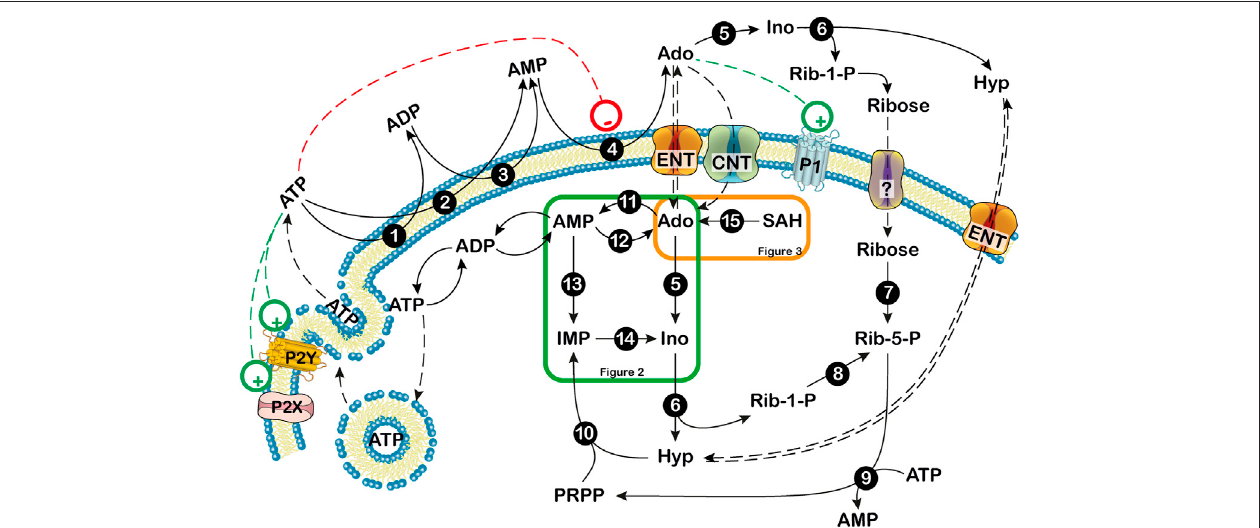
FIGURE 1 | Extra- and intracellular adenosine production. Extracellularly, ATP can be dephosphorylated to AMP by ectonucleoside triphosphate diphospho- hydrolase (CD39) or ecto-nucleotide pyrophosphatase/phosphodiesterase. Then, AMP can be dephosphorylated to adenosine by the extracellular 5 ′ -nucleotidase, CD73. Extracellular adenosine can be converted into hypoxanthine (Hyp) and ribose-1 phosphate (Rib-1-P) by the combined action of ectosolic adenosine deaminase and purine nucleoside phosphorylase. Extracellular Rib-1-P might be dephosphorylated by membrane phosphatases and equilibrates with the intracellular ribose through a not yet de fi ned transporter (?). Inside the cell, at low energy charge, adenosine originates mainly from AMP and can be exported or deaminated. When extracellularadenosinegeneratedfromATPbreakdownistransportedinsidethecell,itmightbephosphorylatedbythelowK M ADKordeaminatedbythehighK M ADAif adenosine reaches high levels. 1,3: ecto-nucleoside triphosphate diphosphohydrolase; 2: ecto-nucleotide pyrophosphatase/phosphodiesterase; 4: ecto-5 ′ - nucleotidase; 5: adenosine deaminase; 6: purine nucleoside phosphorylase; 7: ribokinase; 8: phosphoribomutase; 9: 5-phosphoribosyl-1-pyrophosphate synthetase; 10: hypoxanthine guanine phosphoribosyltransferase; 11: adenosine kinase; 12: cytosolic 5 ′ nucleotidase I; 13: AMP deaminase; 14: cytosolic 5 ′ nucleotidase II; 15: S-adenosylhomocysteine hydrolase. Ado: adenosine; CNT: concentrative nucleoside transporter; ENT: equilibrative nucleoside transporter; Hyp: hypoxanthine; Ino: inosine; P1: purinergic receptor type 1; P2: purinerigic receptor type 2; Rib-1-P: ribose-1-phosphate; Rib-5-P: ribose-5-phosphate. Green and orange boxes indicate that these pathways are described in more details in Figures 2 , 3 . +: stimulation; -: